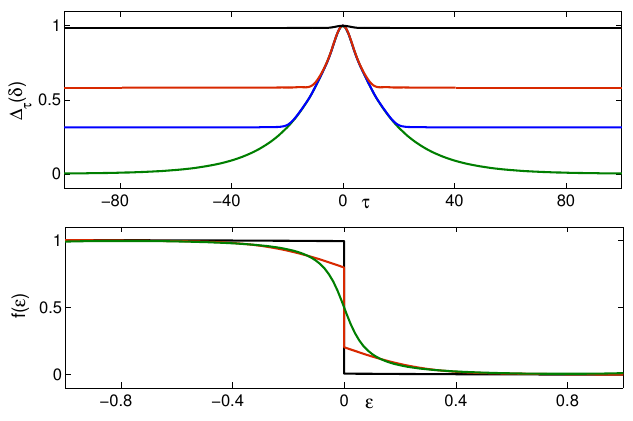
/ t = 10 is plotted e v